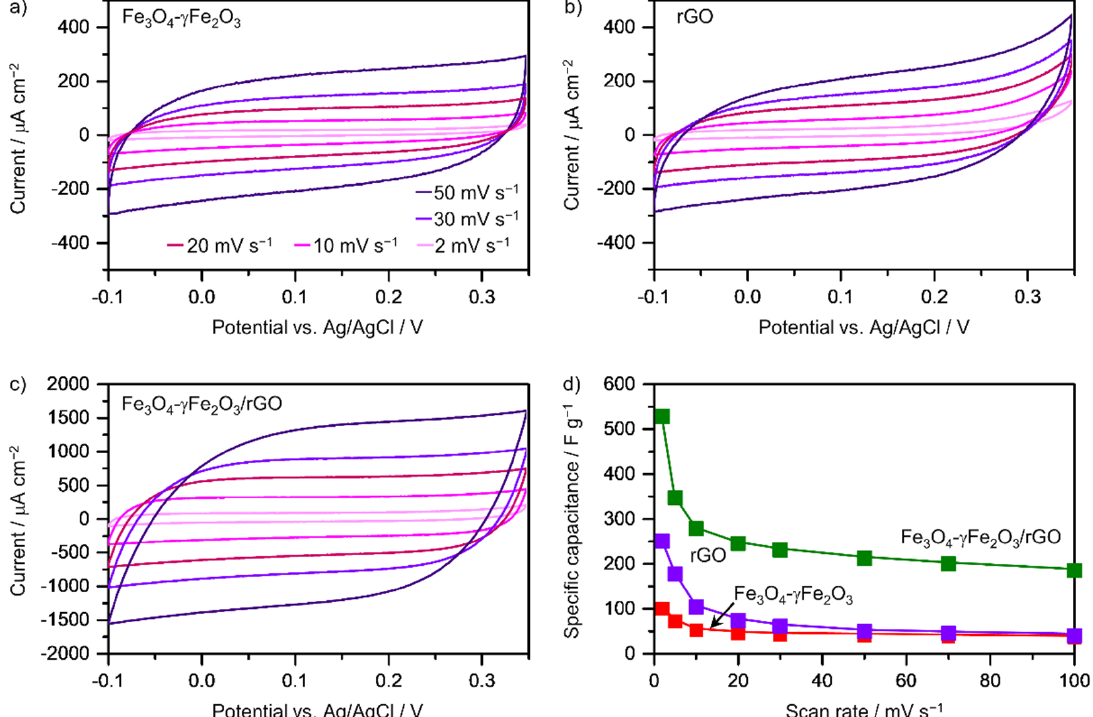
Figure 3. Cyclic voltammetries of ( a ) clusters of Fe 3 O 4 / γ -Fe 2 O 3 nanoparticles, ( b ) rGO sheets and ( c ) rGO-Fe 3 O 4 / γ -Fe 2 O 3 nanocomposite material at different scan rates. ( d ) Specific capacitance as a function of the scan rate for the three materials under study. Experimental conditions: 3 M KOH solution, room temperature.